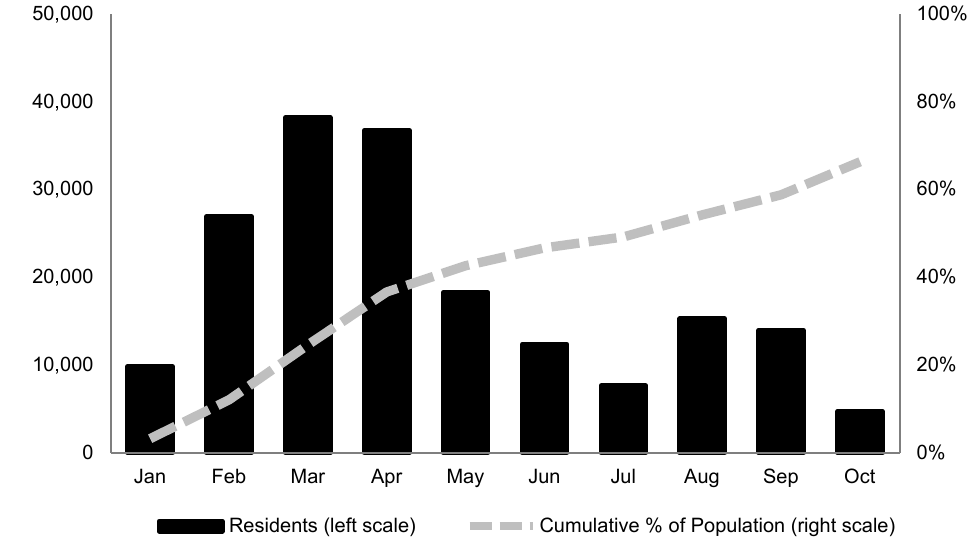
Figure 1. Fully vaccinated population in Nueces County, age 12 and